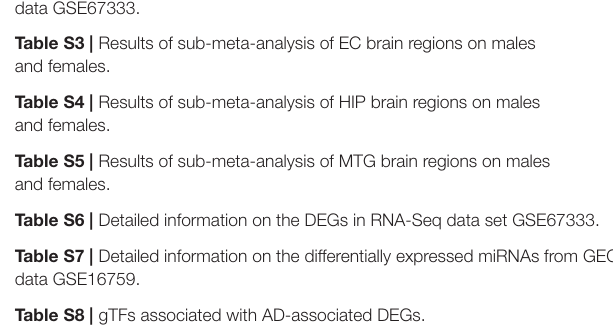
Table S1 | Detailed descriptions of the samples including the brain regions, sex and mean age. Table S2 | Detailed information on the RNA-Seq samples collected from GEO data GSE67333. Table S3 | Results of sub-meta-analysis of EC brain regions on males and females. Table S4 | Results of sub-meta-analysis of HIP brain regions on males and females. Table S5 | Results of sub-meta-analysis of MTG brain regions on males and females. Table S6 | Detailed information on the DEGs in RNA-Seq data set GSE67333. Table S7 | Detailed information on the differentially expressed miRNAs from GEO data GSE16759. Table S8 | gTFs associated with AD-associated DEGs. Table S9 | gTFs associated with other neurodegenerative disease-associated DEGs. Table S10 | mTFs associated with AD-associated miRNAs. Table S11 | mTFs associated with other neurodegenerative disease-associated miRNAs. Table S12 | Feed-forward loop from the mTF–miRNA–gene–gTF regulatory networks. Table S13 | Important SNPs in AD and their related AD-associated miRNAs and